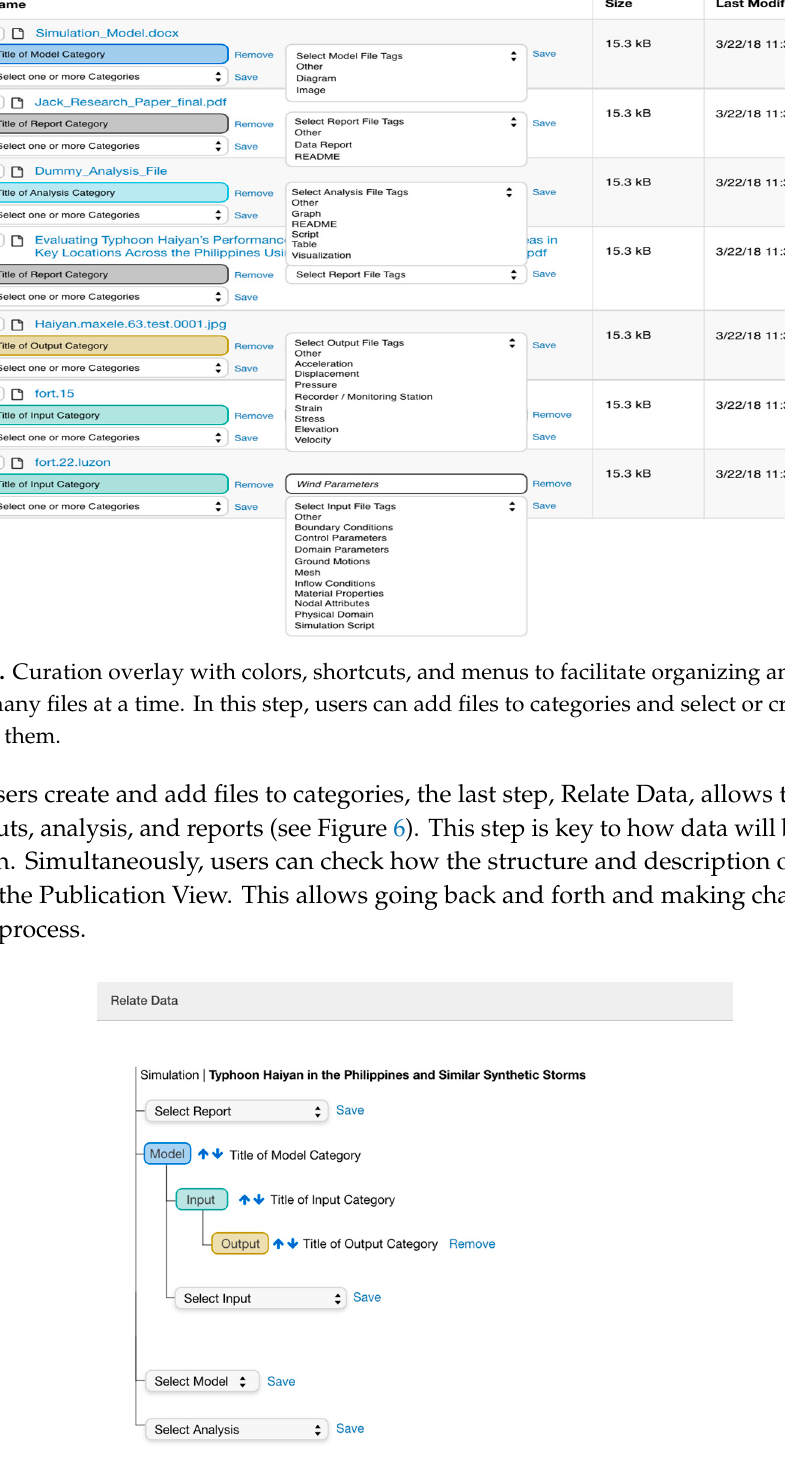
Figure 4. Overview of data organization instructions ( left ) and Add Categories steps ( right ) in the interactive curation interface. Note onboarding help such as the meaning of each category and tips to write titles and descriptions.